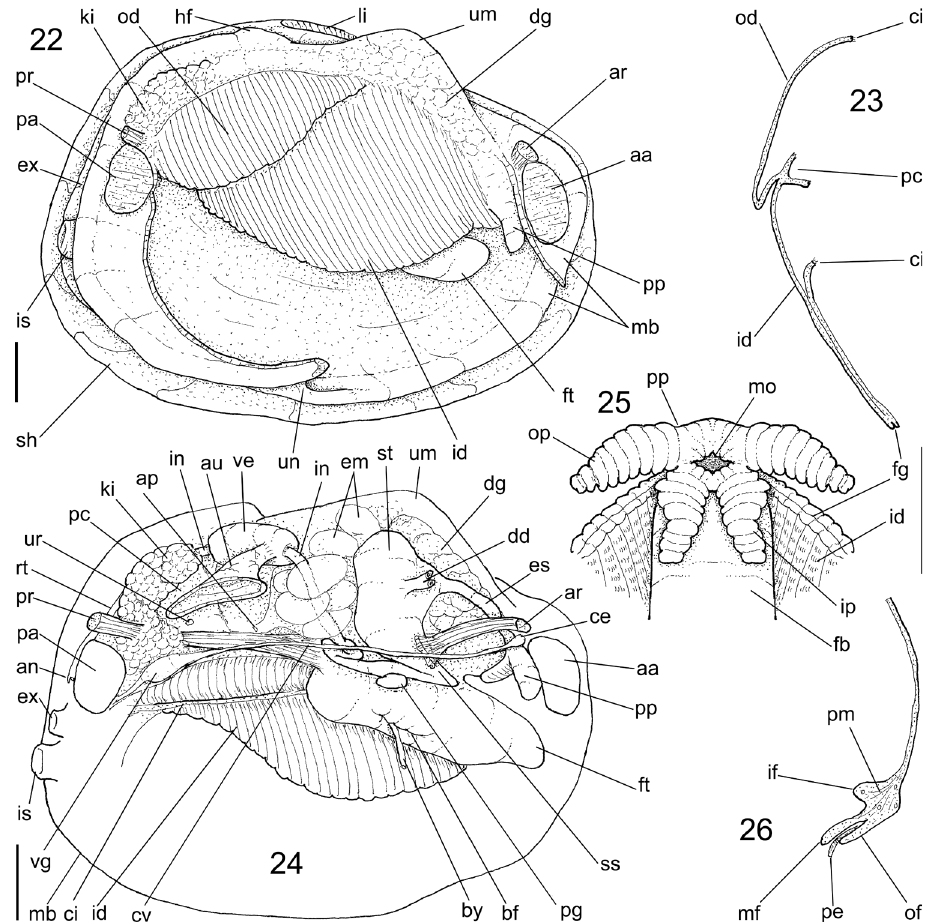
Figures 22–26. Eupera troglobia anatomical drawings 22 whole right view, right valve and part of right mantle lobe removed 23 gill, transverse section in its middle level 24 whole right view, right gill removed, visceral structures seen as in situ if region was transparent, peripherical structures with only topology indicated 25 palp region, ventral view, hemipalps slightly deflected 26 mantle edge, transverse section in middle level of ventral edge. Scale bars: 0.5